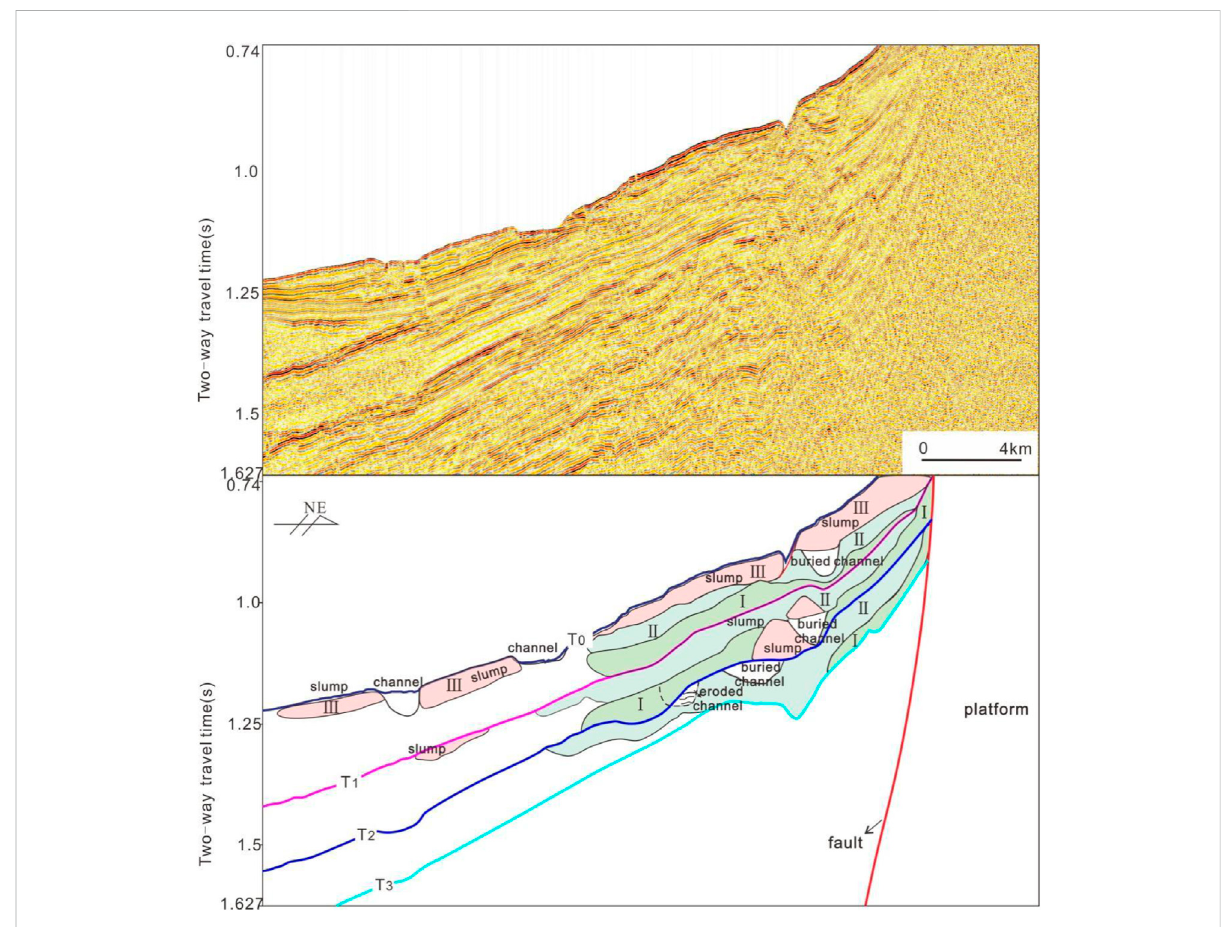
FIGURE 6 Landslides and ancient channel sediments of different stages in the northwest of Xuande